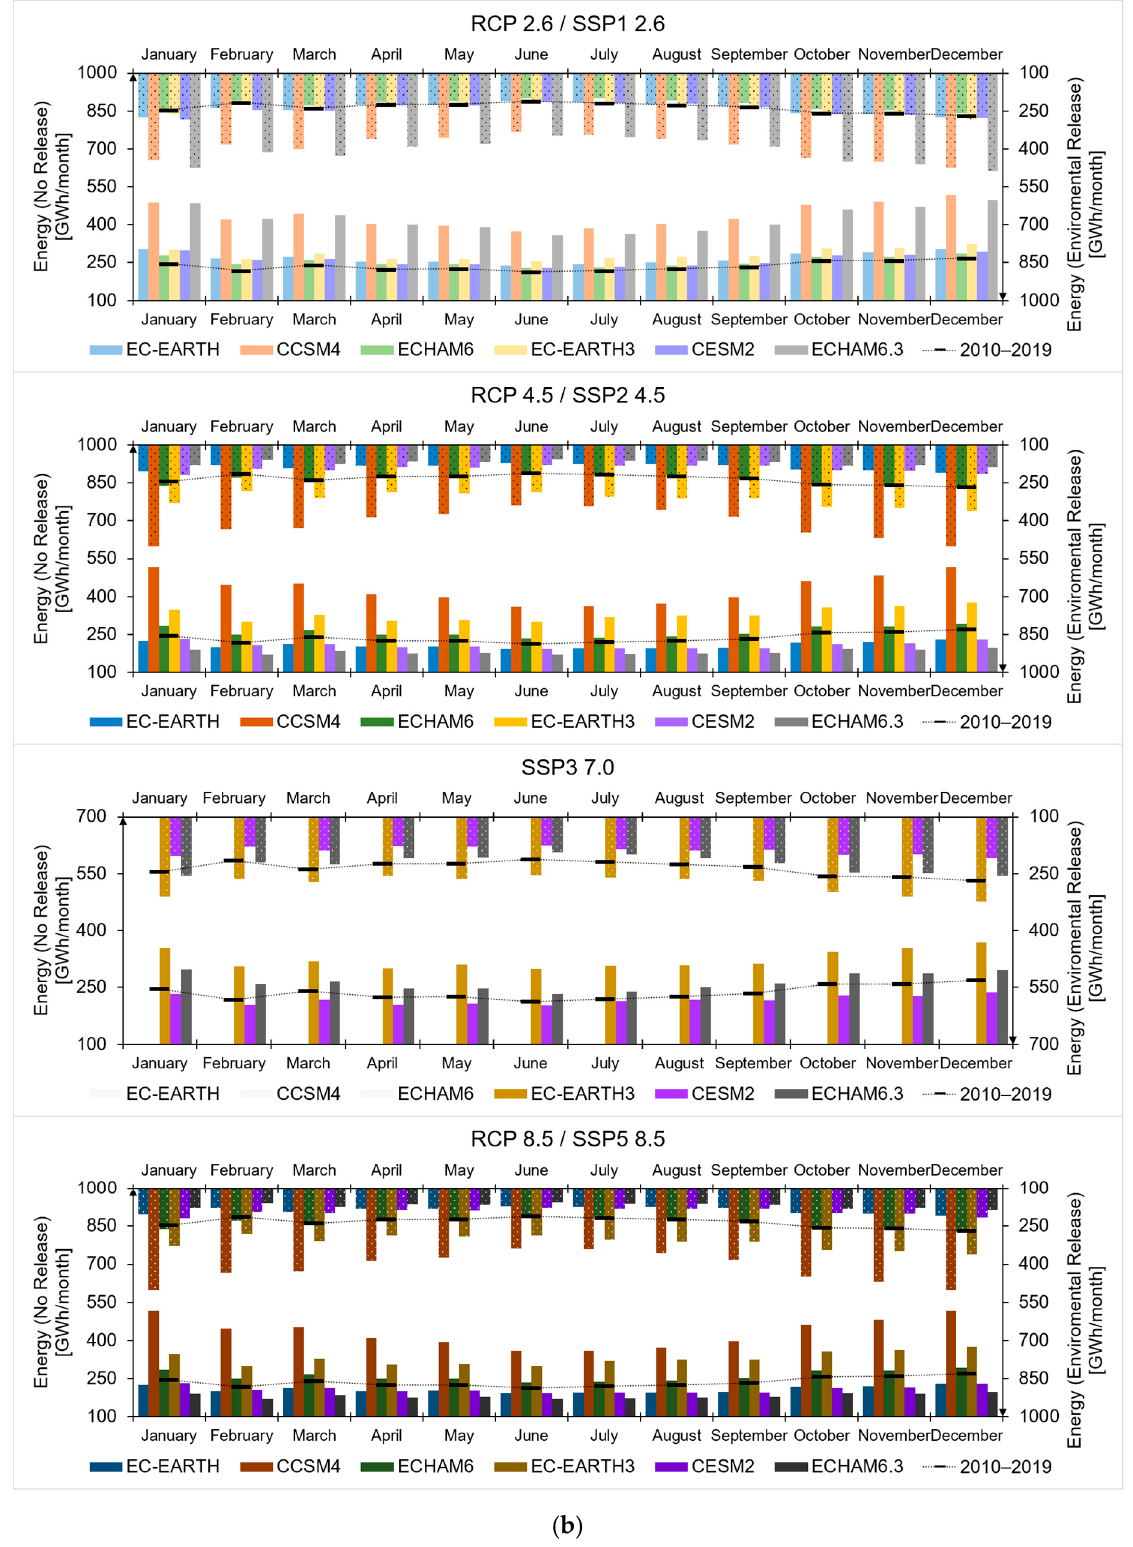
Figure 10. GIBE III. Average estimated monthly hydropower production. ( a ) Mid Century P1. ( b ) End of Century P2.